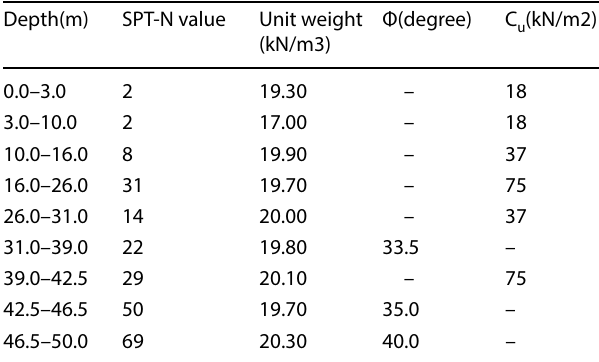
Table 2 Typical soil properties of NKD soil of Ultadanga site (after Roy et al. 2018 [66])